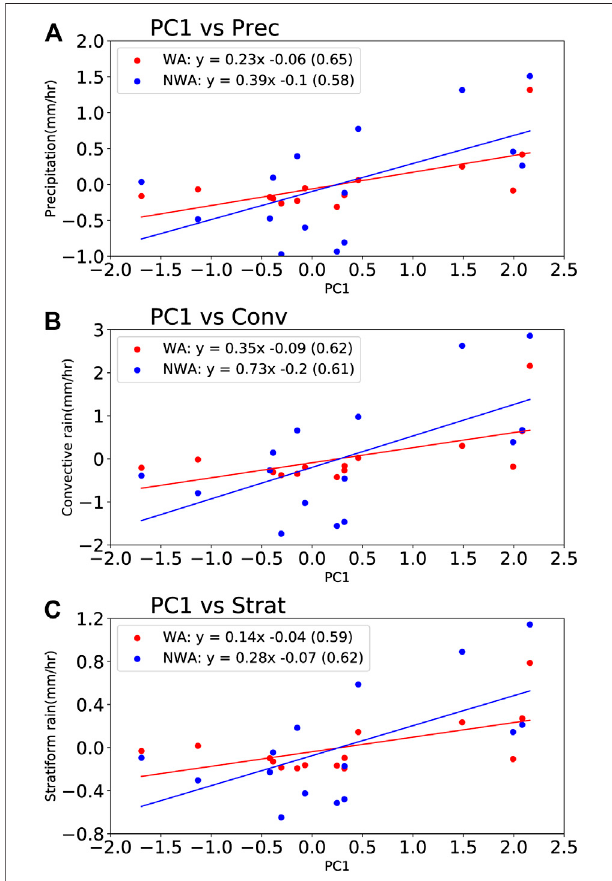
FIGURE 2 | Scatter plot of austral summer (DJF) mean (A) total precipitation rate, (B) convective precipitation rate, and (C) stratiform precipitation rate averaged over the WA (red dots) and NWA (blue dots) coastal regions during 1998 – 2013. The horizontal axis is the value of PC1. The red (blue) solid line denotes the linear regression for the WA (NWA) coastal region, and the regression equation and its associated correlation coef fi cients are shown on the top in each